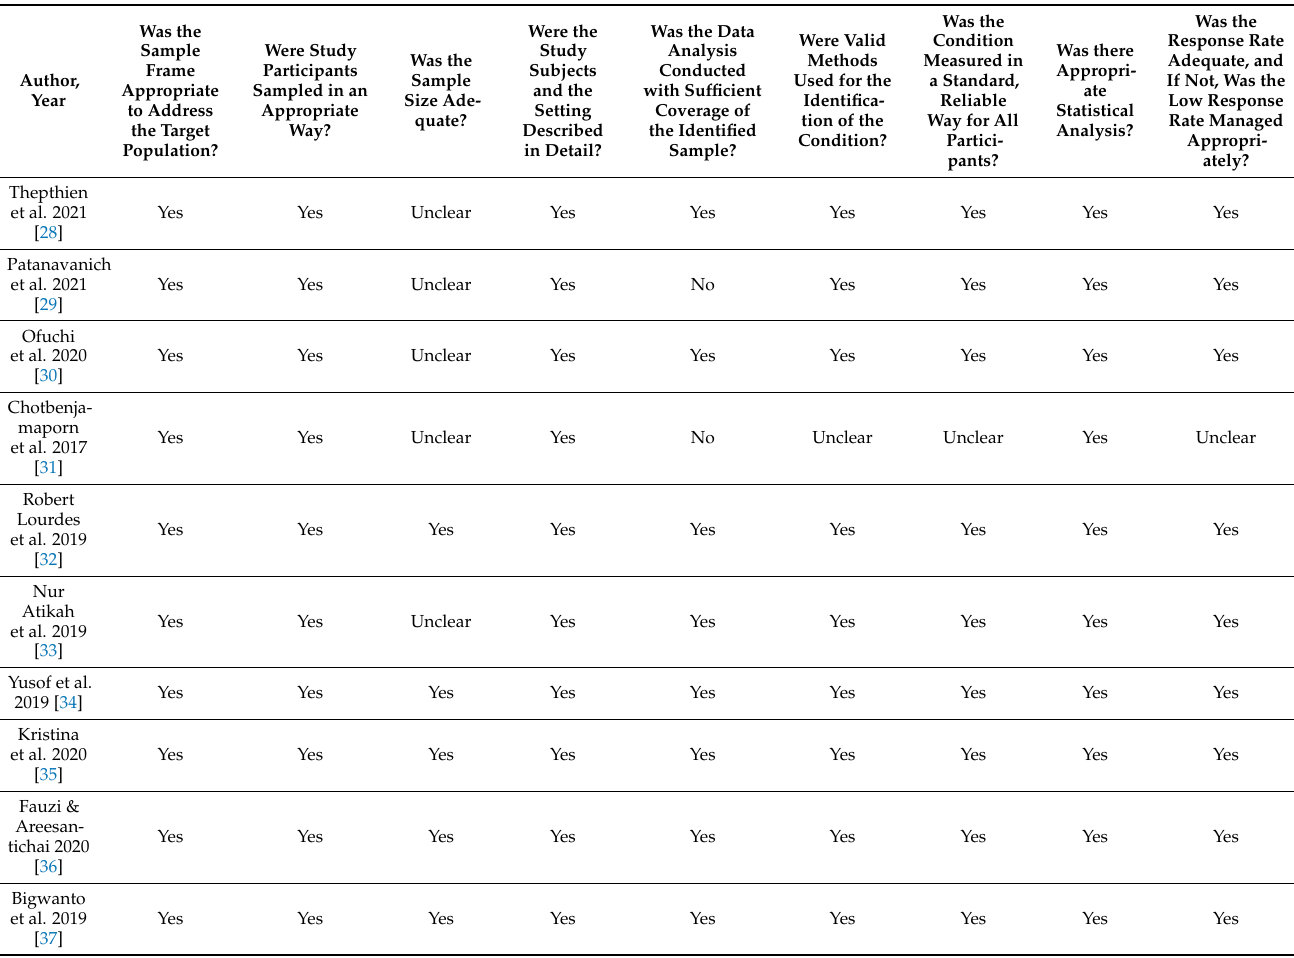
Table 4. JBI critical appraisal